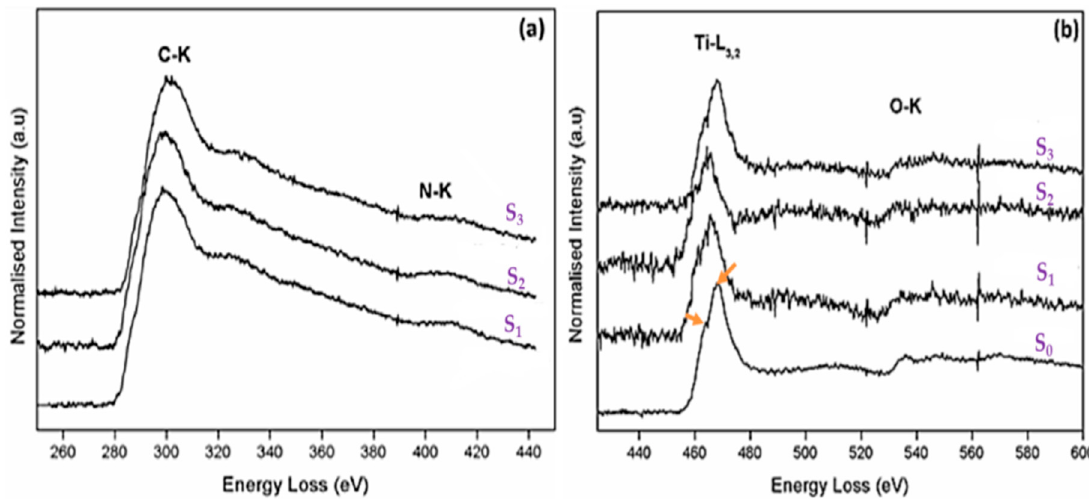
Figure 3. Electron energy-loss spectra of ( a ) carbon K edge and nitrogen K edge line profiles and ( b ) titanium L 3,2 and oxygen K edge line profiles of the different catalysts synthesized by sol-gel method, and pyrolysed at 350 °C at 50 °C/min ramping rate for different times (S 0 = Degussa TiO 2 ; S 1 = C–N–TiO 2 105 min; S 2 = C–N–TiO 2 120 min; S 3 = C–N–TiO 2 135